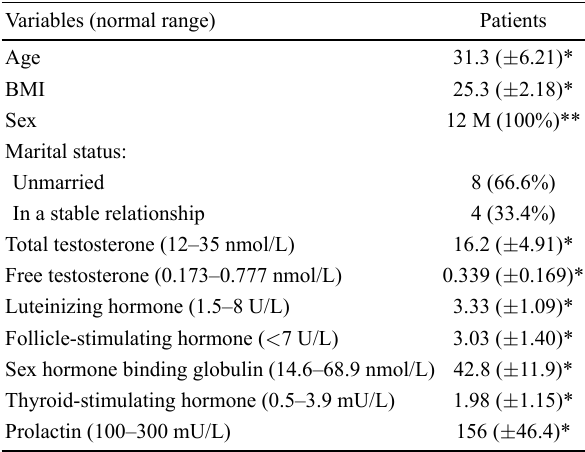
Table 1. Sociodemographic and clinical